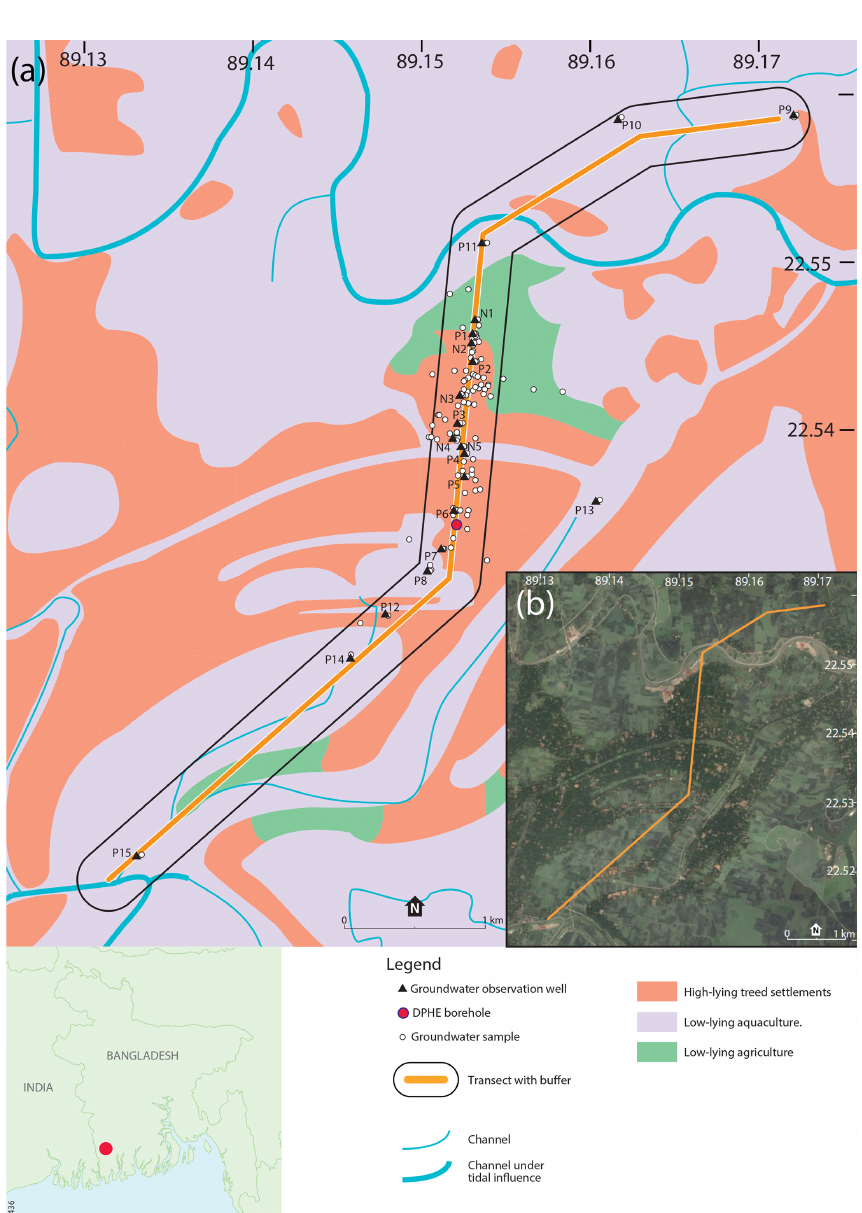
Figure 1. (a) Overview of the study area, indicating the transect and groundwater observation points, land use and current surface water channels. The land use types are based on satellite imagery (b) , SRTM data, a soil map (FAO, 1959) and field observations. The location of the Department of Public Health Engineering (DPHE) borehole is indicated in the figure. (b) Satellite imagery of the study area (ESRI,